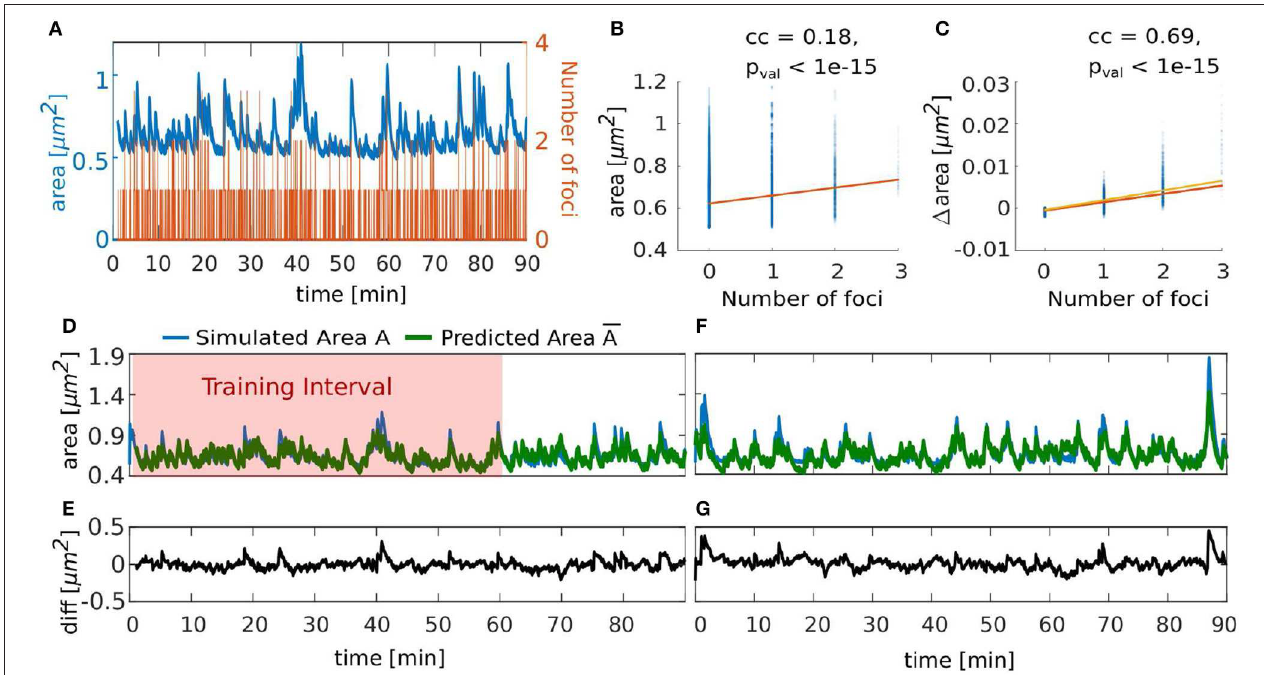
FIGURE 11 | Temporal evolution of spine area can be predicted by number of actin polymerization foci. (A) Evolution of number of actin polymerization foci (orange line) and spine area (blue line). (B) Spine area over the number of actin polymerization foci for each time-step of the simulation. Color saturation indicates overlay of data points; darker regions contain more data observations. Orange line is a linear fit to the data, cc denotes the linear correlation coefficient and pval is the p -value for testing the hypothesis of no correlation against the alternative hypothesis of a non-zero correlation, using Pearson’s Linear Correlation Coefficient. (C) Same for the difference in spine area over the number of actin polymerization foci. Yellow line is a linear function using the parameters fitted to Equation (8) in (D) . (D) Simulated area (blue line) and its approximation by estimator A (green line, Equation 8) over time. Red shaded zone depicts the training data set for fitting the estimator parameters. (E) Difference between simulated and predicted area in (D) . (F) Simulated area (blue line) corresponding to the plot in Figure 5B and its approximation (green line) over time. (G) Difference between the simulated and predicted area in (F)